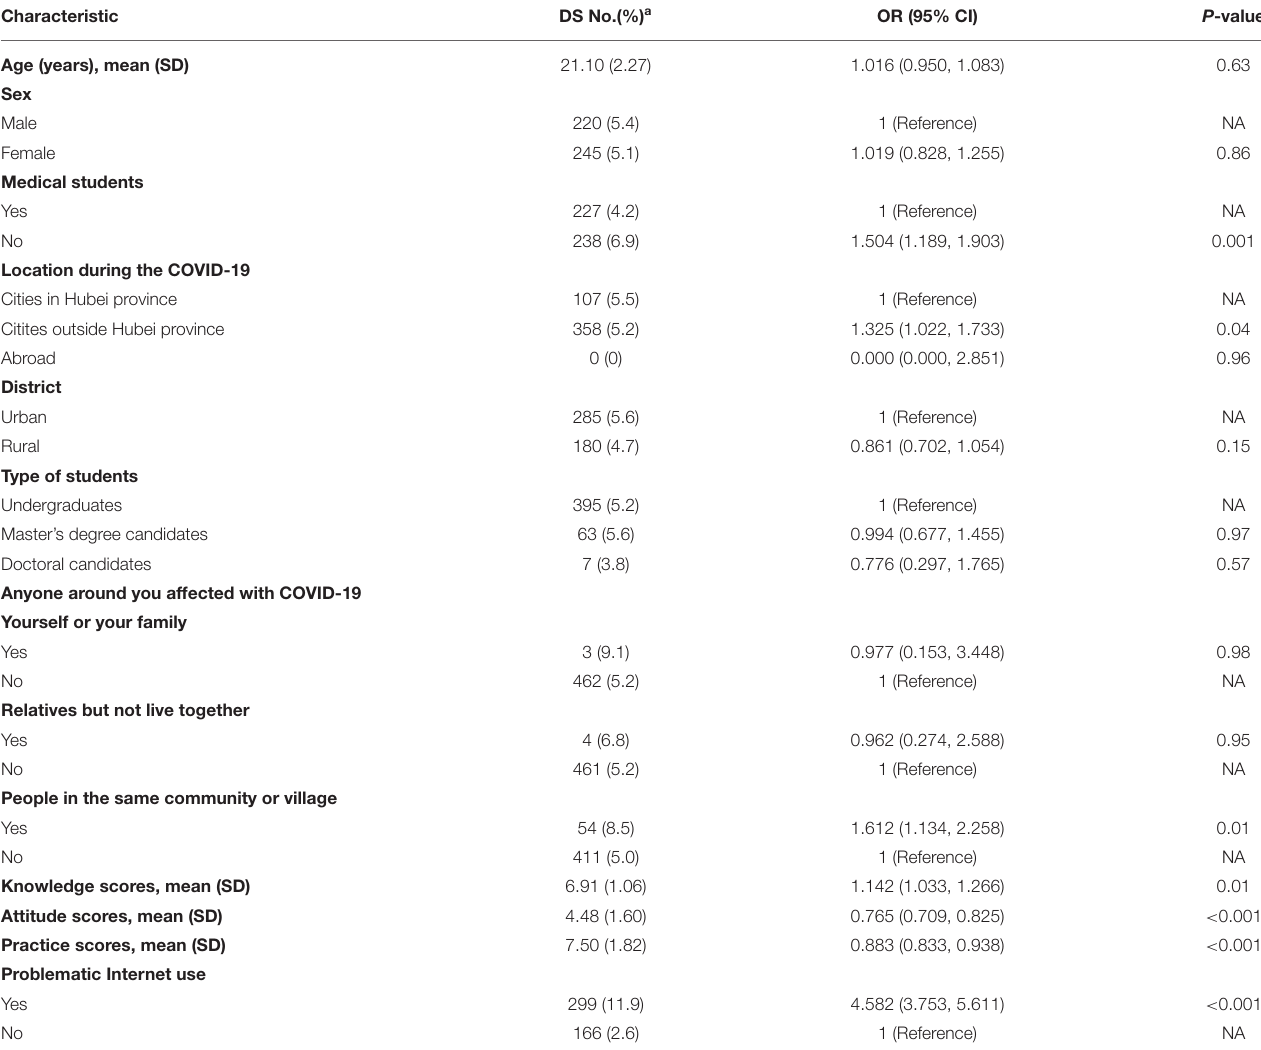
TABLE 3 | Characteristics of participants according to the depressive symptoms.